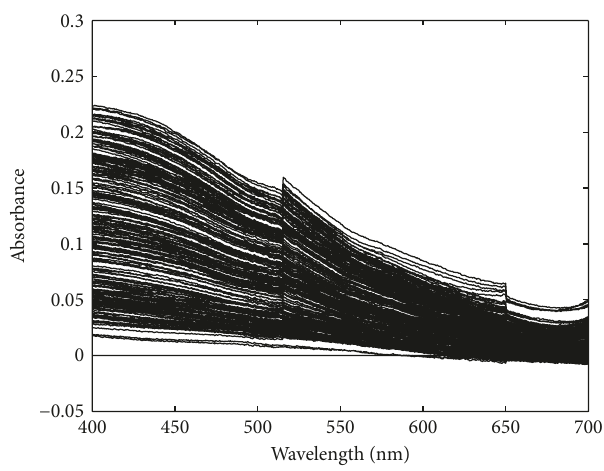
Figure 1: Spectra of the UA